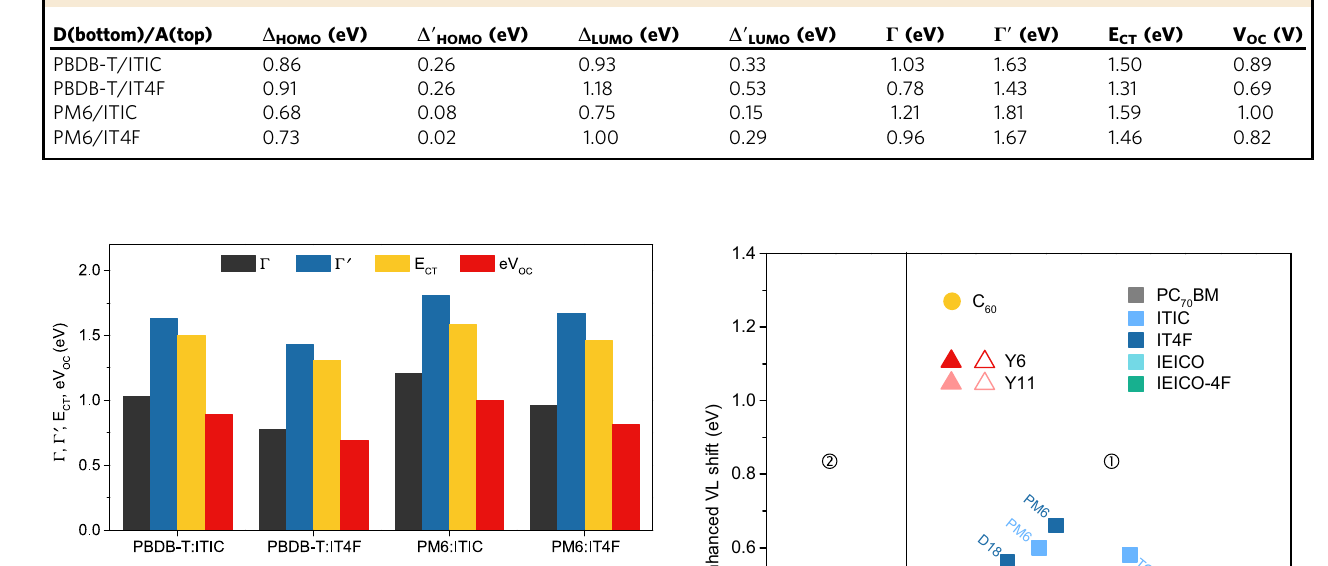
Table 2 Summary of the energetic offset Δ HOMO ( Δ ′ HOMO ), Δ LUMO ( Δ ′ LUMO ), photovoltaic gap Γ ( Γ ′ ) between donor (D) and acceptor (A) before (after) VL shift correction, as well as the charge-transfer state energy (E CT ) and open-circuit voltage (V OC ) values measured in devices.